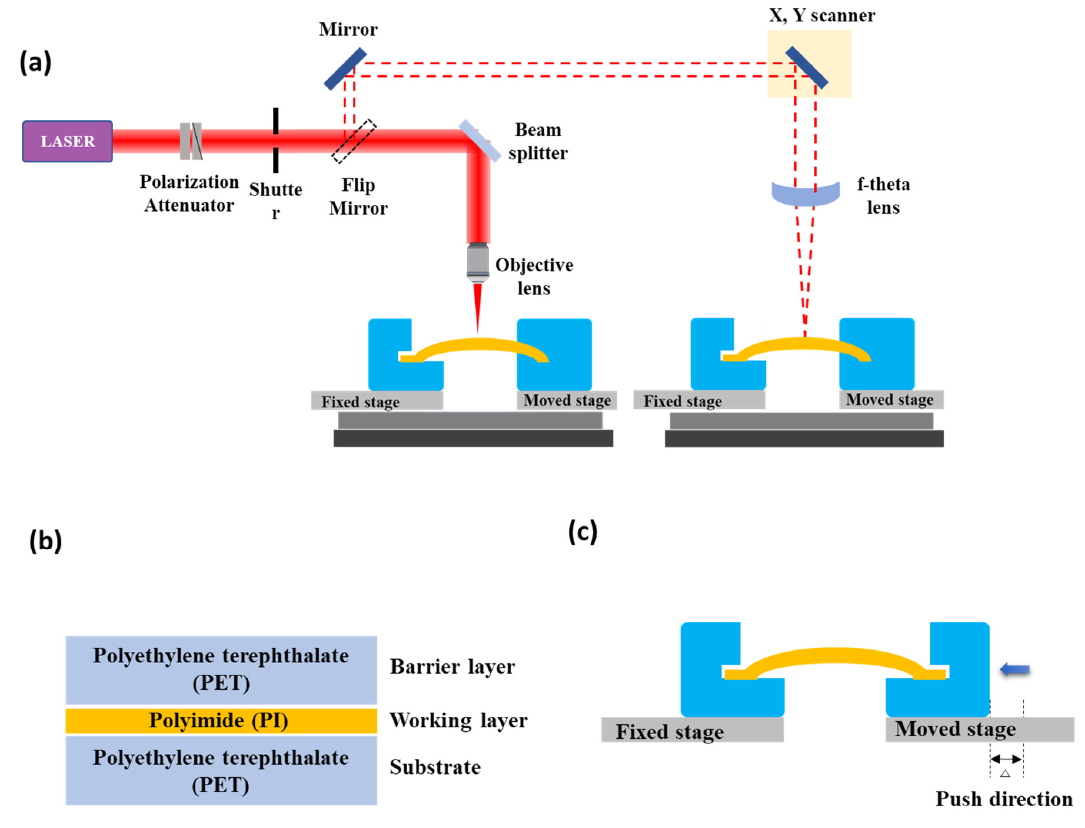
Figure 1. ( a ) Overview of laser processing system in which an objective lens-based and F-theta lens-based optical systems ( b ) schematic diagram of multi-layer polymer sample (Simplified flexible device) ( c ) Overview of the experiment method that generates a fine curvature as a preliminary preparation.